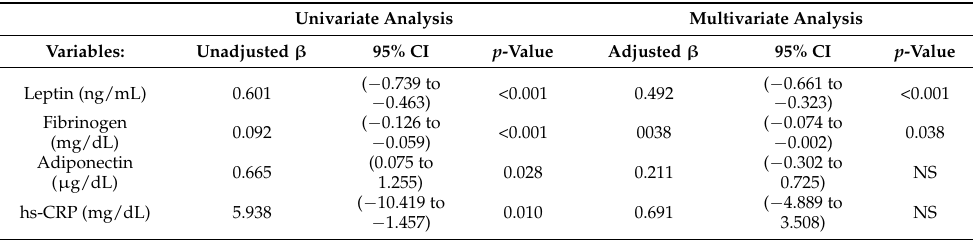
Table 4. Linear regression model explaining cardiorespiratory fitness (VO 2max ) adjusted for the level of adiposity (BMIz) and biochemical parameters.